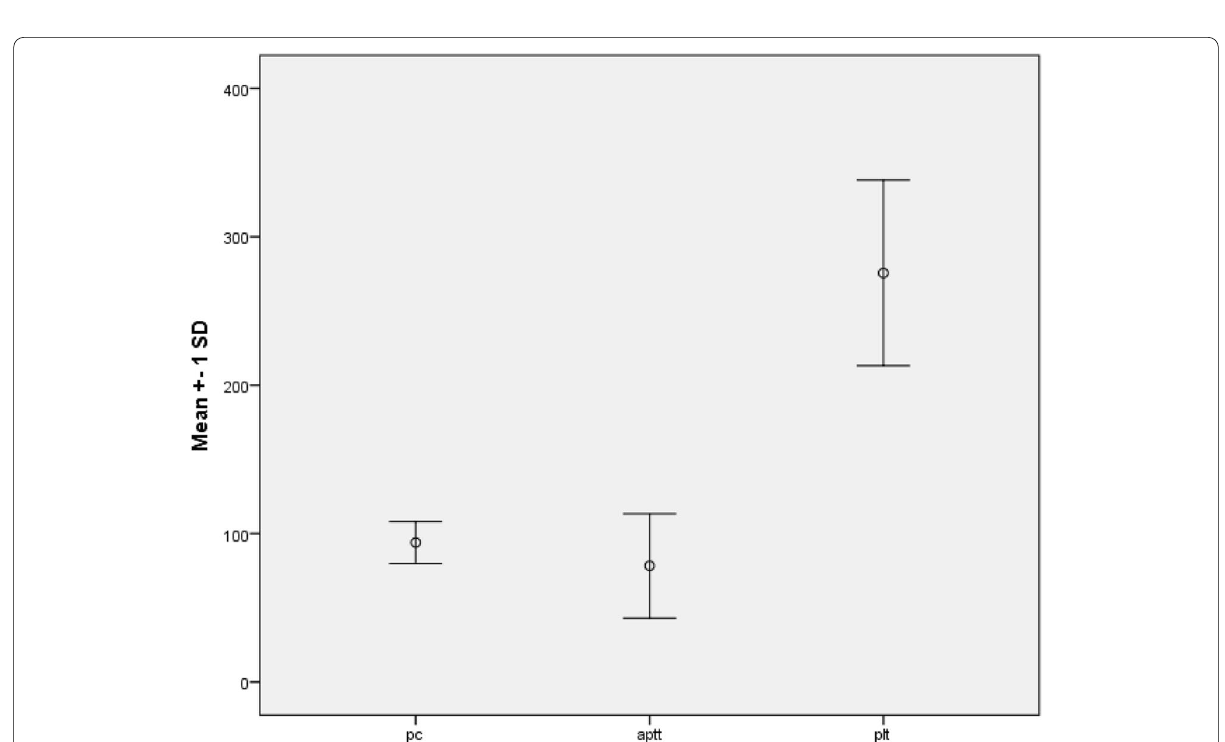
Fig. 4 Clinical investigations (PC, APTT, and platelet) in the studied